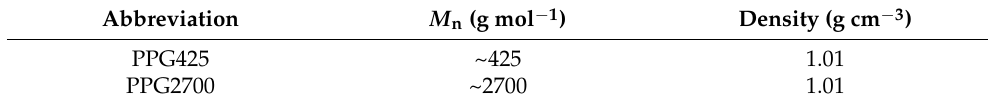
Table 1. Properties of poly(propylene glycol) 1 .